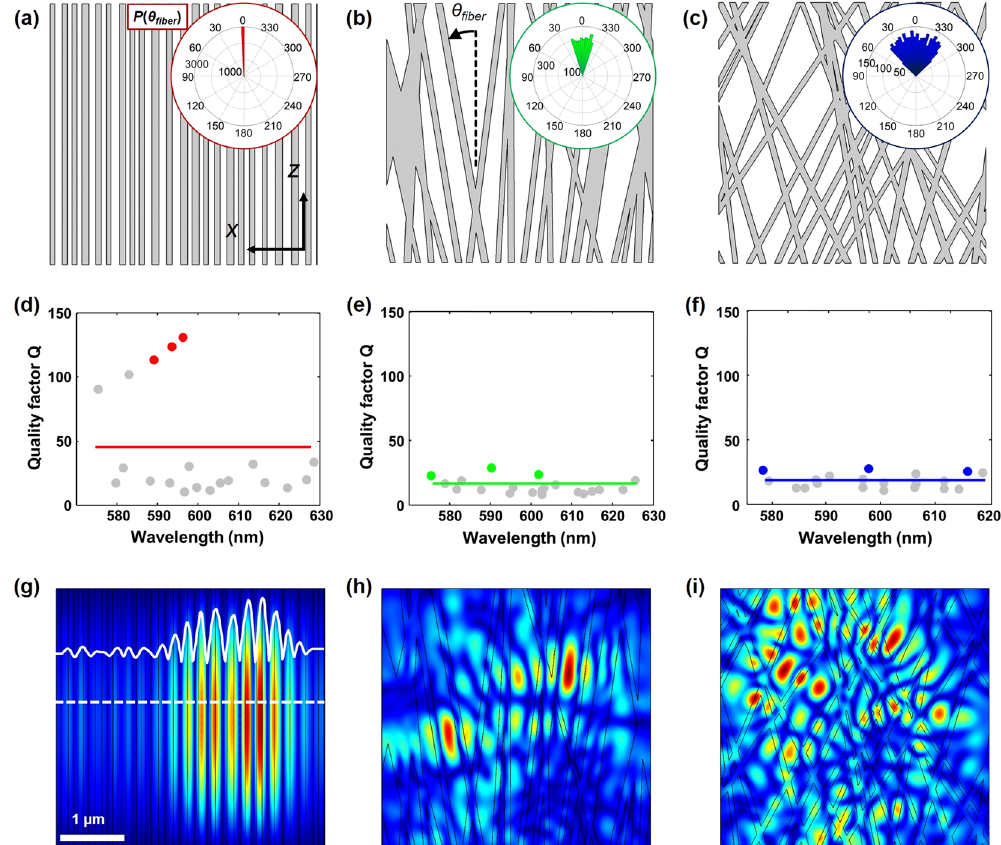
Figure 4. ( a – c ) SF nanofiber configurations for the FEM quasi-mode analysis. Histograms of the angular distribution of the SF nanofibers are presented in the insets of ( a – c ). ( d – f ) Quality factors as a function of wavelengths for the three cases. Solid lines denote the Q AVE . ( g – i ) Amplitudes and spatial distributions of the electric fields corresponding to the three modes with the highest Q factors. These modes are indicated by the red, green and blue dots in ( d – f ),